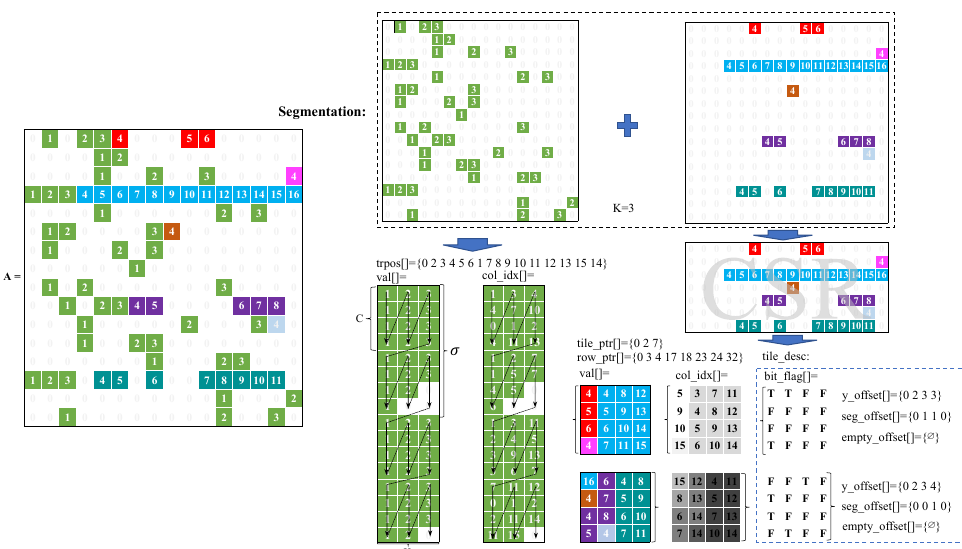
Figure 4. Represent a sparse matrix A with the HYB5 format. How a sparse matrix A is represented in HYB5 and SELL-C- σ . In this example, matrix A is of 16 × 16 size and has 76 non-zeros. Colored cells denote non-zero elements, and white cells are zeros. The arrows indicate the memory accessing